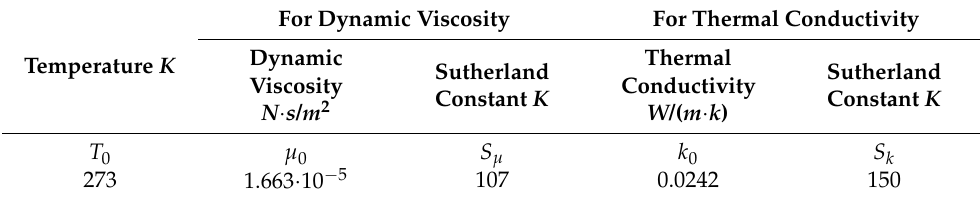
Table 1. Sutherland’s law parameters. For Dynamic Viscosity For Thermal Temperature K